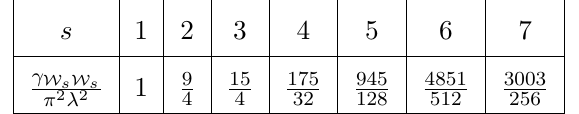
Table 5 . Matrix elements γ W